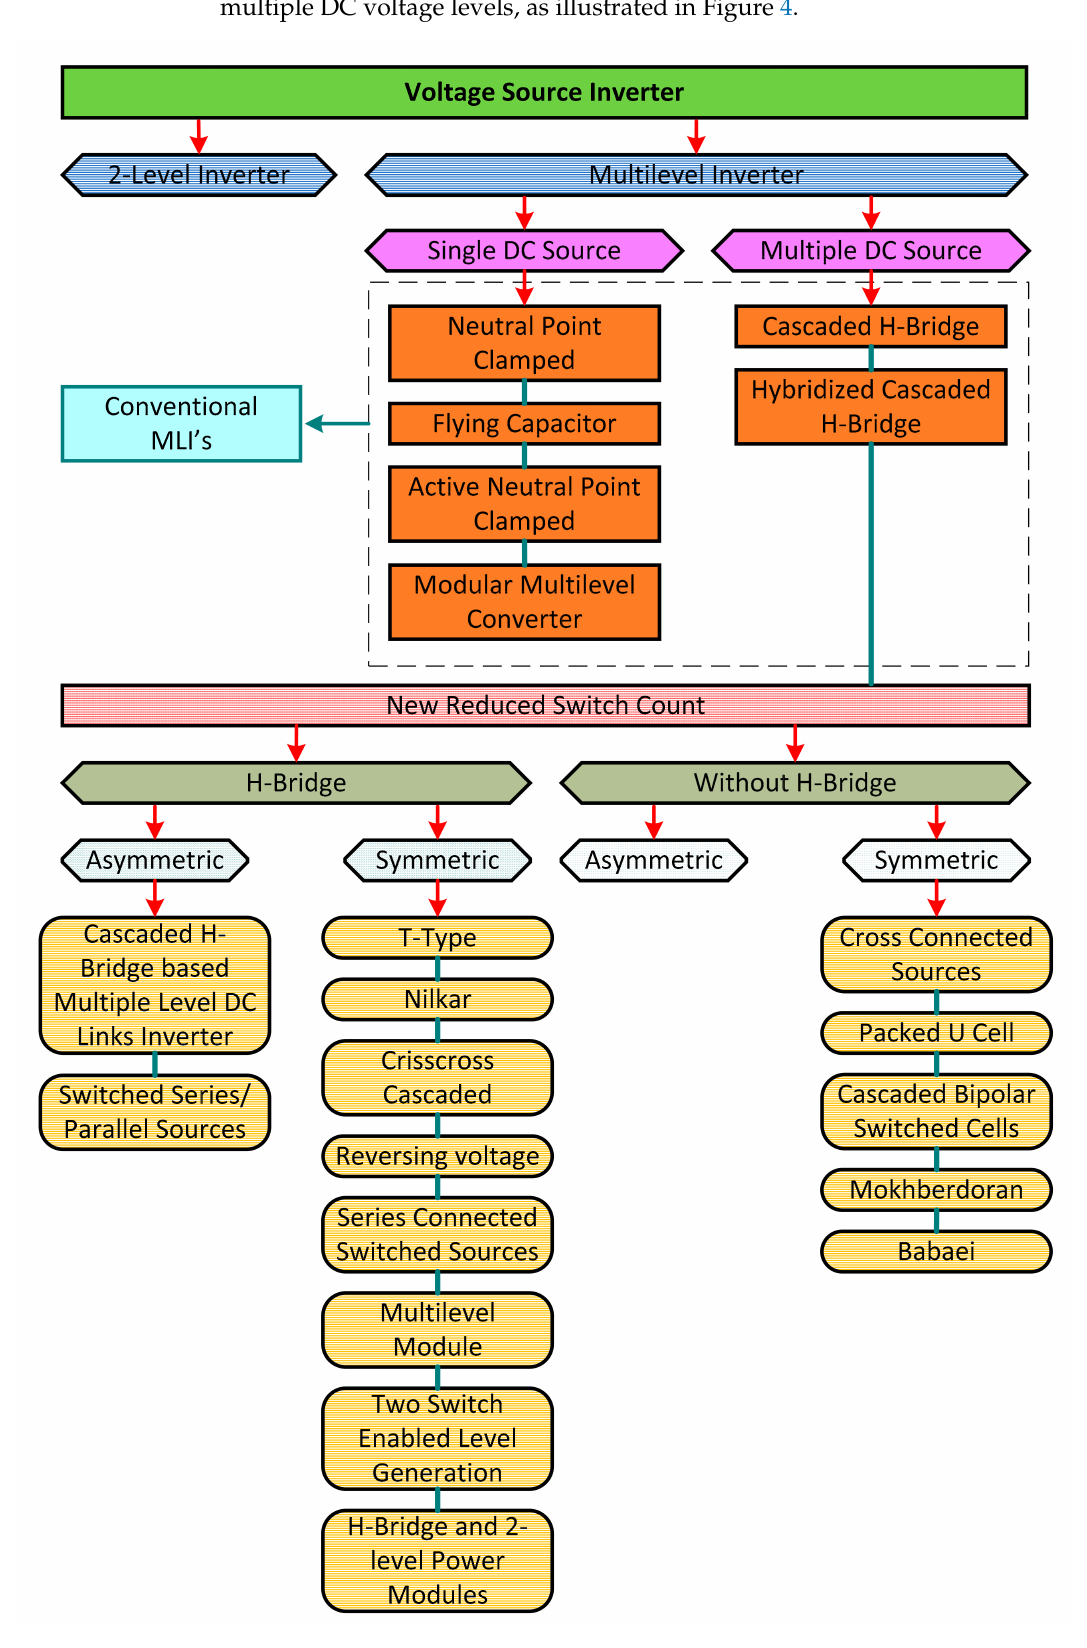
Figure 3. Overall classification of